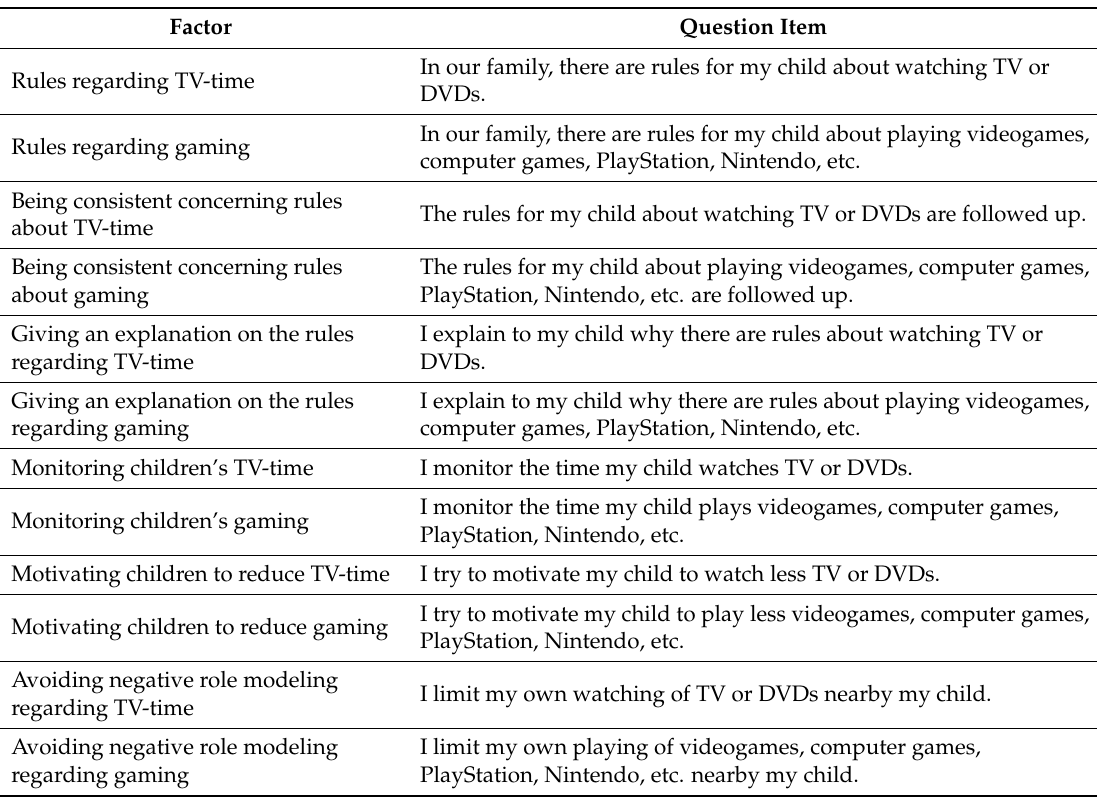
Table 1. Formulations of the questionnaire items of the specific parenting practices related to